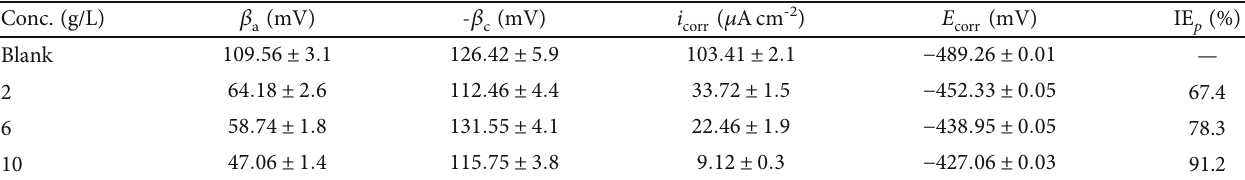
Figure 1: The e ff ect of various CMSE concentrations on the electrochemical behavior of A515 Grade 70 carbon steel in 1M NaCl solution at 303K. Table 3: Polarization parameters and corrosion inhibition e ffi ciency of A515 Grade 70 carbon steel in 1 M NaCl solution at 303 K in the absence and presence of various concentrations of